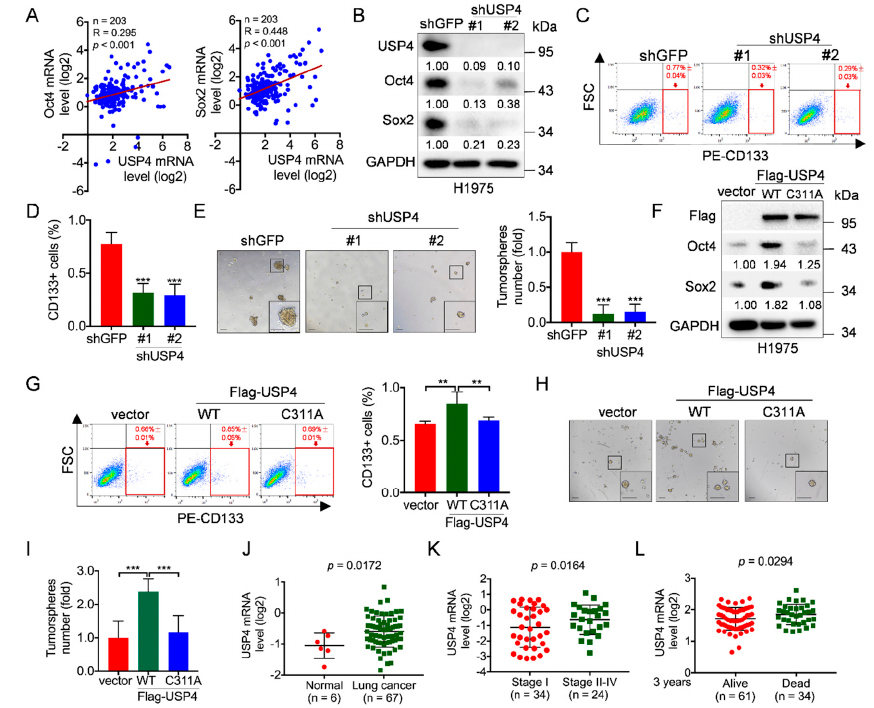
Figure 1. USP4 promotes lung cancer cell stemness and its high expression is correlated with human lung cancer patients. ( A ) The Oncomine dataset “Bhattacharjee Lung” was used to analyze Pearson correlation of USP4 and Oct4 / Sox2 expression. ( B – E ) H1975 cells stably expressing shRNA against USP4 (shUSP4-#1 or shUSP4-#2) were subjected to ( B ) Western blot analyses, ( C – D ) FACS analyses for CD133-stained cells or ( E ) tumorsphere formation assay. Respective images and quantitation were shown. Data from three independent experiments in triplicates were presented as means ± SD. *** p < 0.001. Scale bar = 100 μ m. ( F – I ) H1975 cells stably expressing Flag-USP4 or Flag-USP4 C311A were subjected to ( F ) Western blot analyses, ( G ) FACS analyses for CD133-stained cells or ( H – I ) tumorsphere formation assay. Respective images and quantitation were shown. Data from three independent experiments in duplicates were presented as means ± SD. ** p < 0.01, *** p < 0.001. Scale bar = 100 µ m. ( J ) The Oncomine dataset “Gaber lung” was used to analyze USP4 mRNA levels in normal human lung tissues and lung cancers. ( K ) The Oncomine dataset “Bild lung” was used to analyze USP4 mRNA levels in stage I or stage II-IV human lung cancers. ( L ) The Oncomine dataset “Raponi lung” was used to analyze USP4 mRNA levels in 3 year-alive or 3 year-dead human lung cancer